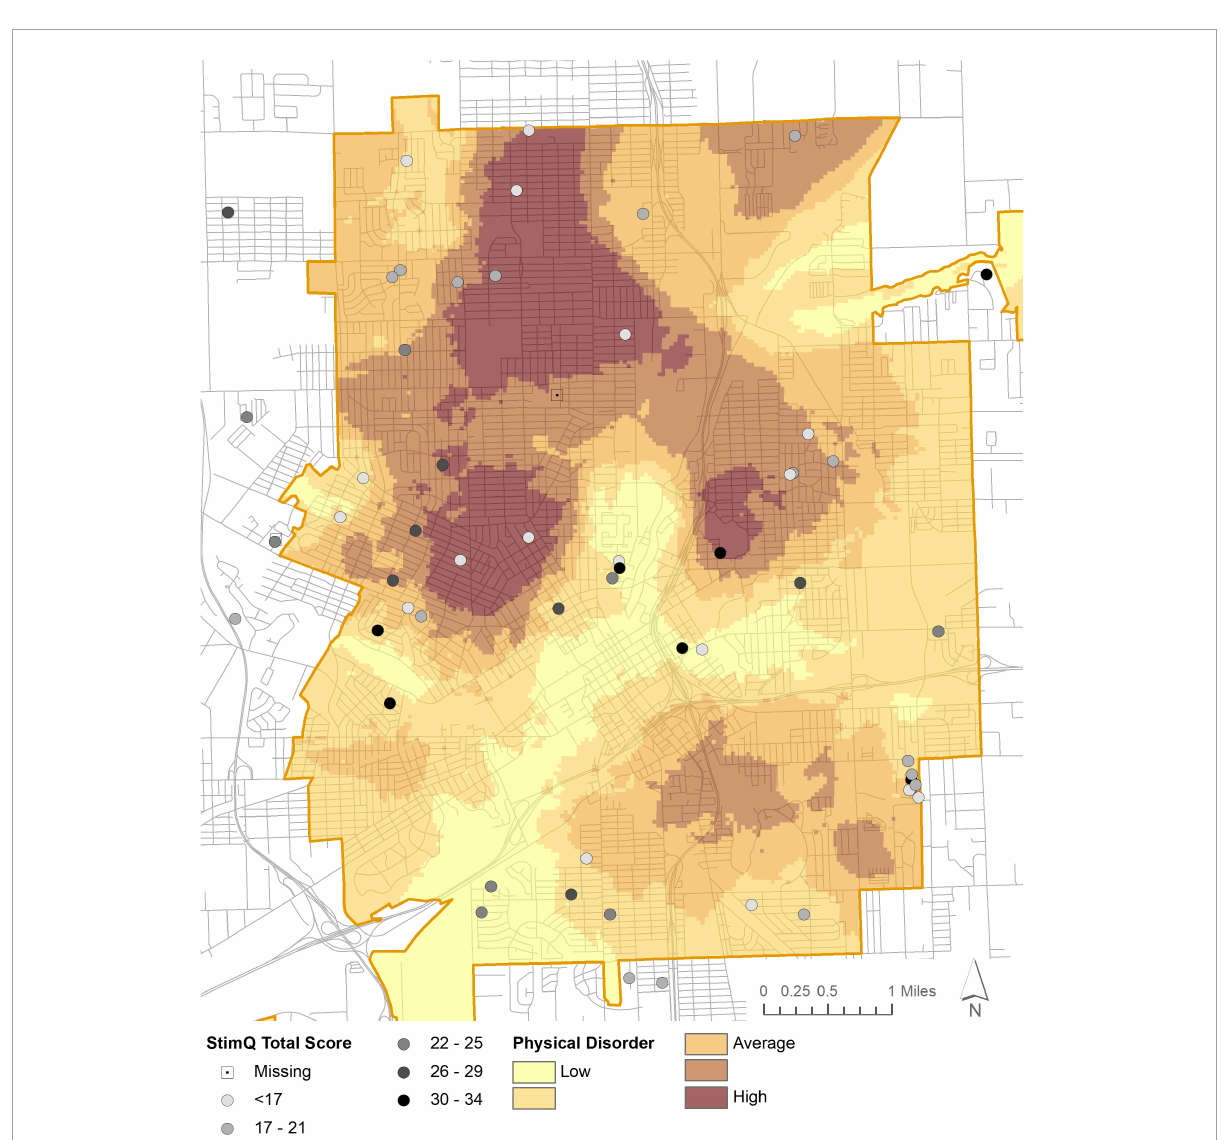
FIGURE2 Parental cognitive stimulation (StimQ 2 ) and NIfETy physical